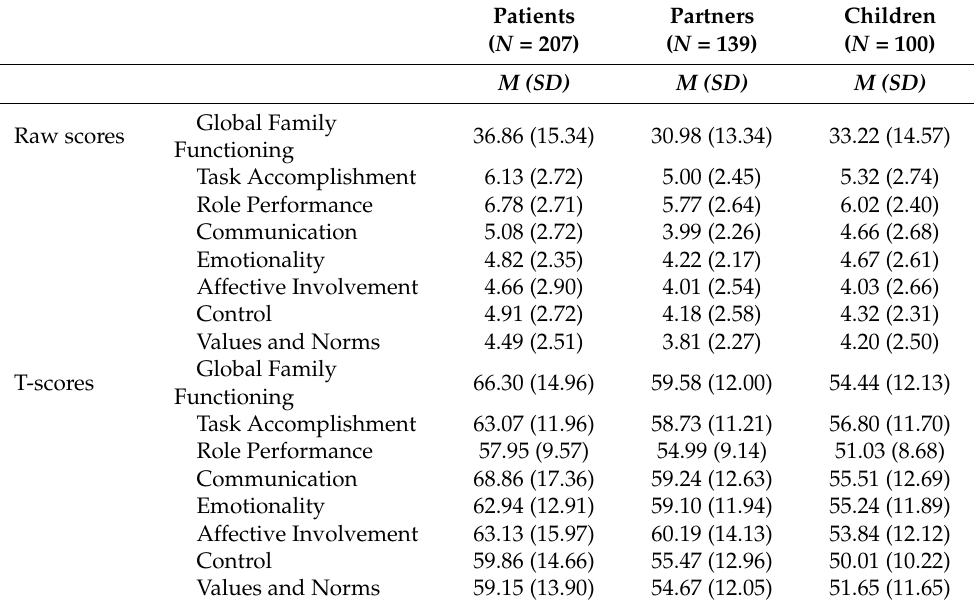
Table 2. Descriptive statistics of the FAM for the different family